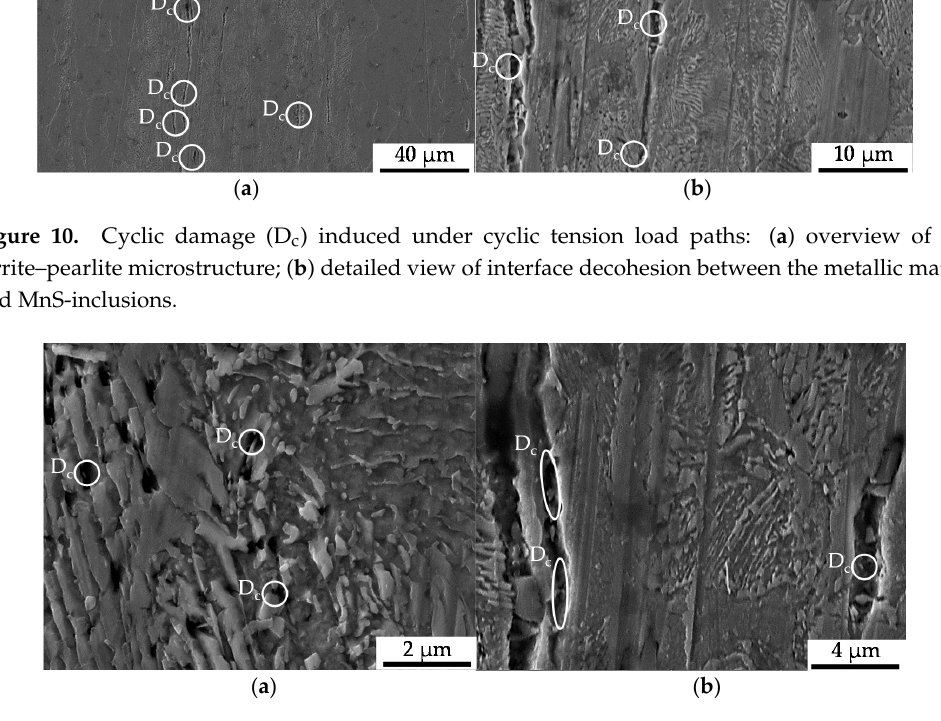
Figure 11. Cyclic damage (D c ) induced under cyclic tension load paths at a higher magnification: ( a ) detailed view of void nucleation in the pearlite phase; ( b ) detailed view of the interface decohesion of the metallic matrix and MnS-inclusions.